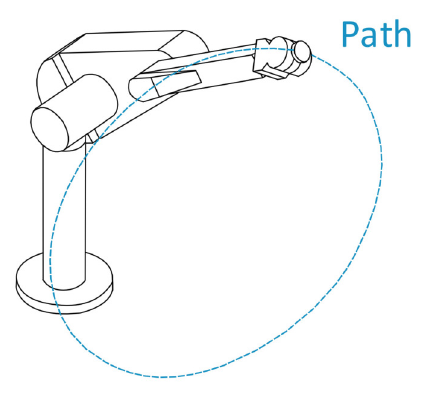
Figure 1. Trajectory tracking with a robot